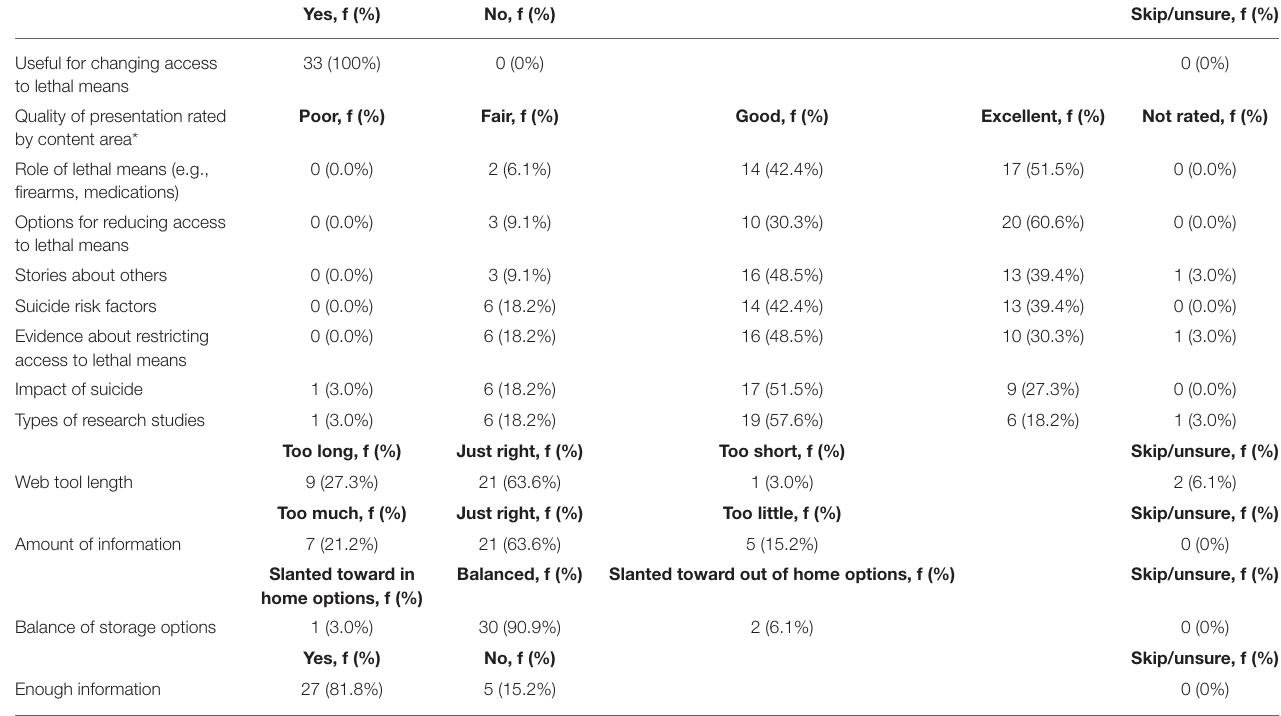
TABLE 3 | Stakeholder ratings of the final version of the “Lock and Protect” decision aid on the acceptability questionnaire ( N =